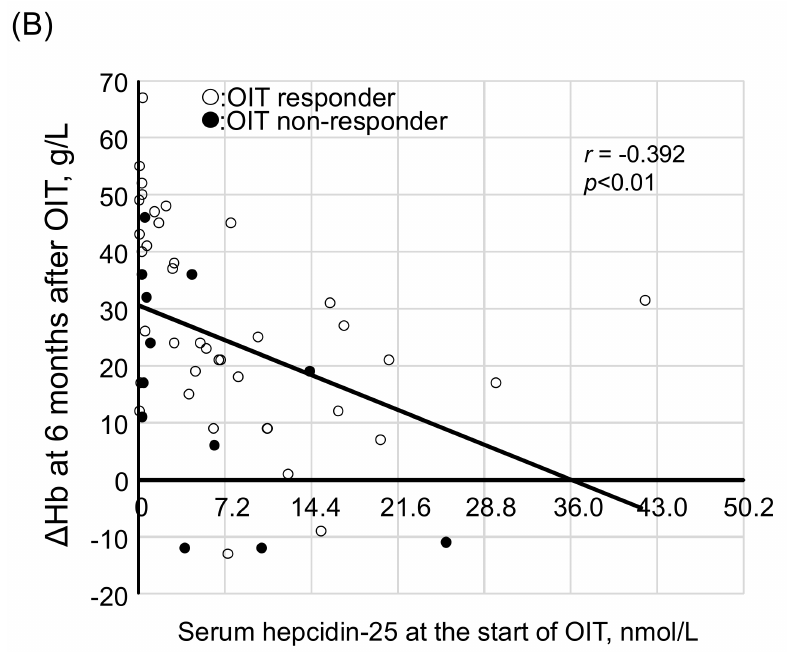
Figure 7. Correlation between serum levels of hepcidin-25 at the start of OIT and ∆ Hb at 3 and 6 months after OIT. Serum levels of hepcidin-25 at the start of OIT were negatively correlated with ∆ Hb at 3 months ( r = − 0.282, p < 0.05) ( A ) and at 6 months ( r = − 0.392, p < 0.01) ( B ) in 51 HD patients. The correlation equation was calculated by Pearson’s correlation coefficient test. White circle: OIT-responders, black circle: OIT-nonreponders.